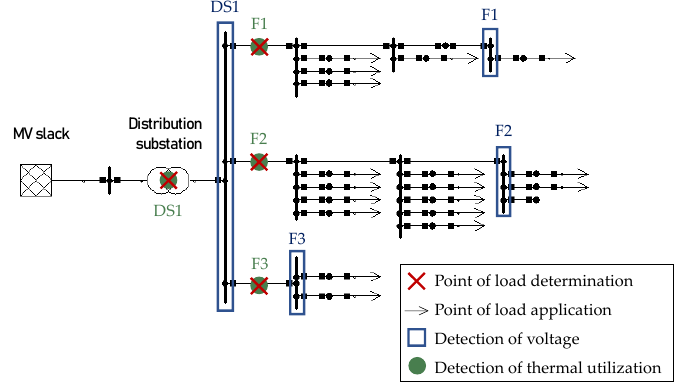
Figure 5. Grid locations of load determination, load application, voltage detection and the detection of thermal